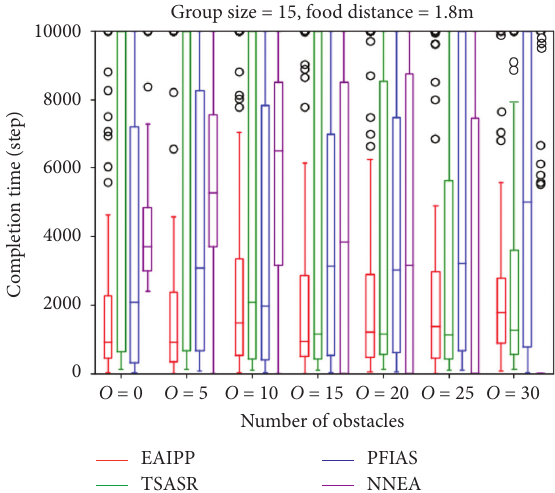
Figure 13: Box-and-whisker plots (Becker et al. 1998 [41]) of obstacle tests (100 observations per box) for a group of 15 robots and a food distance of 1.8 m. See Figure 10 for an explanation of box-and-whisker plots.